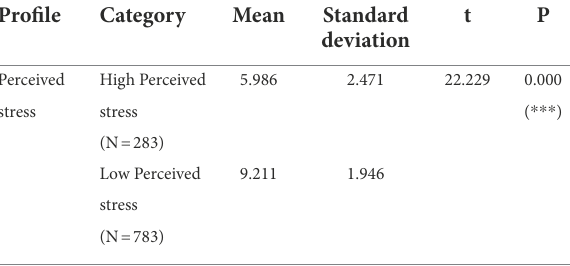
TABLE 4 The result of testing the difference in public acceptance among different perceived stress